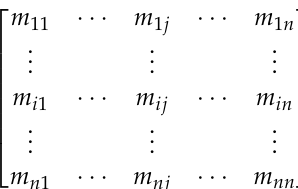
Score Meaning (Row Element to Column Element) 0 No effect 1 Very weak effect 2 Weak effect 3 Strong effect 4 Very strong